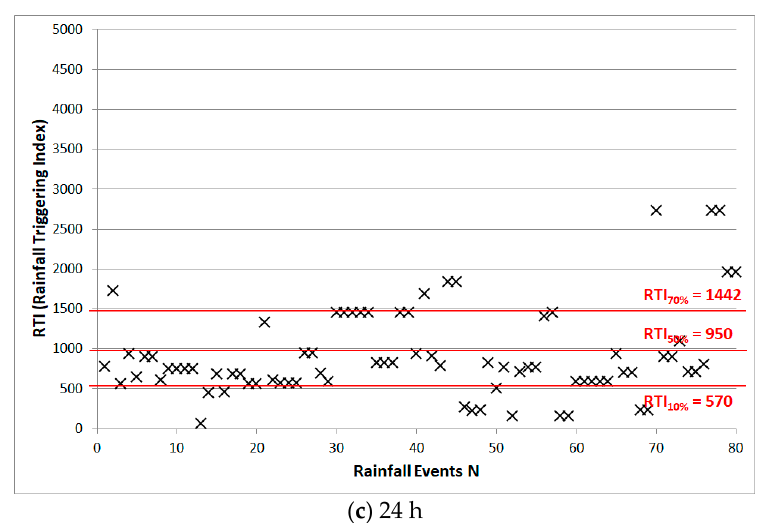
Figure 8. Determination of RTI values according to risk level (a) 6 h; (b) 12 h; (c) 24 h.